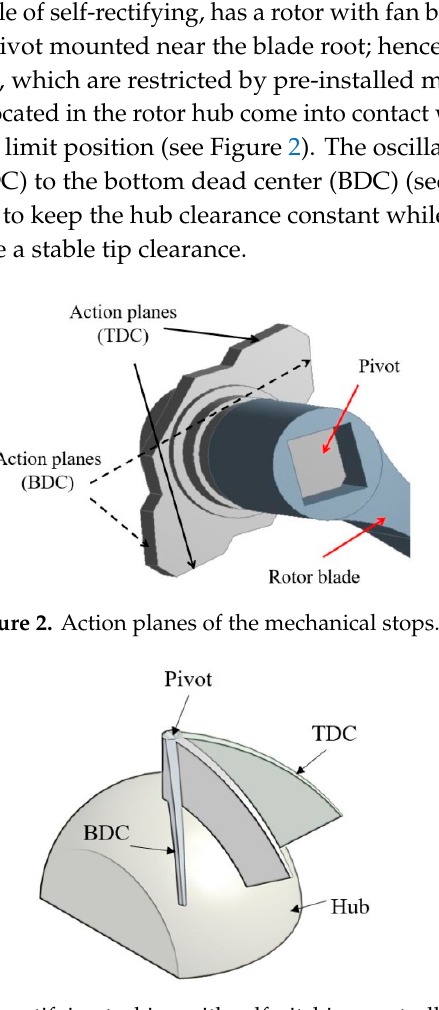
Figure 3. Self-rectifying turbine with self-pitching controlled blades.